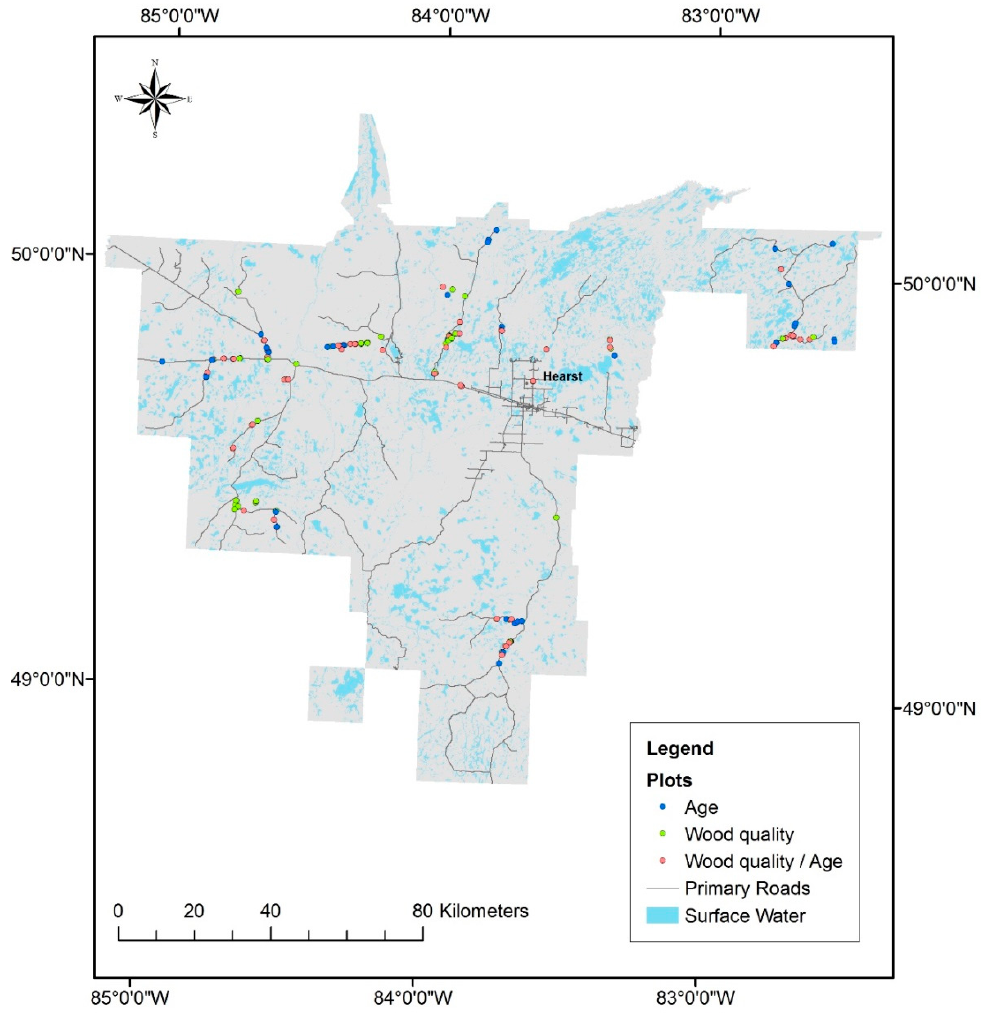
Figure 2. Map of Hearst Forest, with the location of the plots, wood quality project (n = 80), and age prediction model (n = 116).